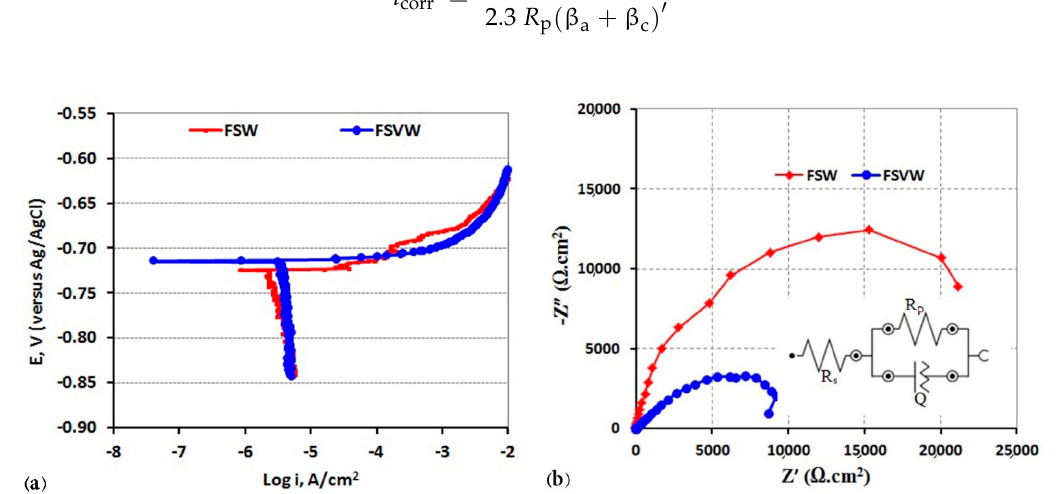
Figure 10. Polarization ( a ) and Nyquist ( b ) curves of FSW and FSVW samples.